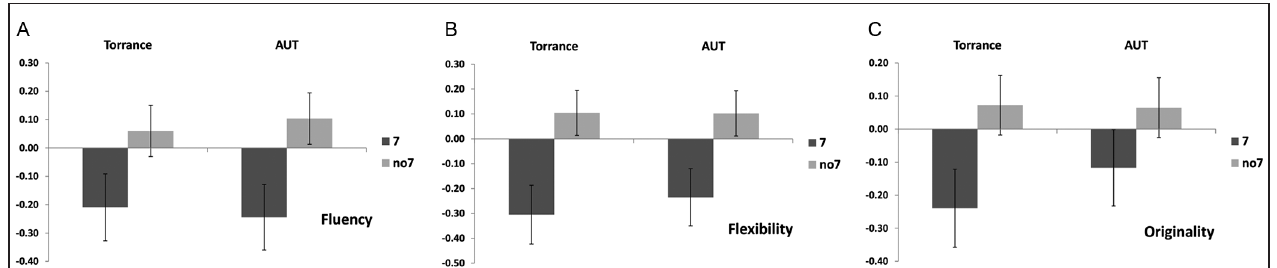
FIGURE 1 | Creativity scores on the AUT and Torrance tasks separated to fluency (A), flexibility (B) and originality (C) . Means were transformed into Z